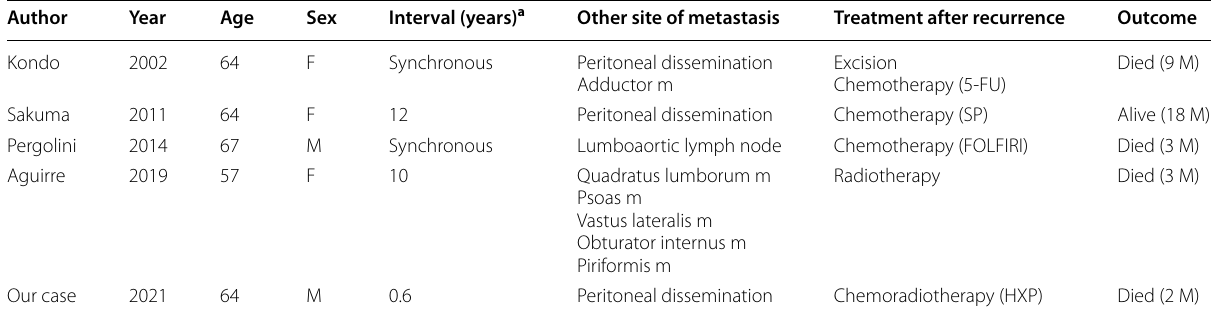
Table 1 Review of reported cases of gluteal muscle metastasis from gastric cancer